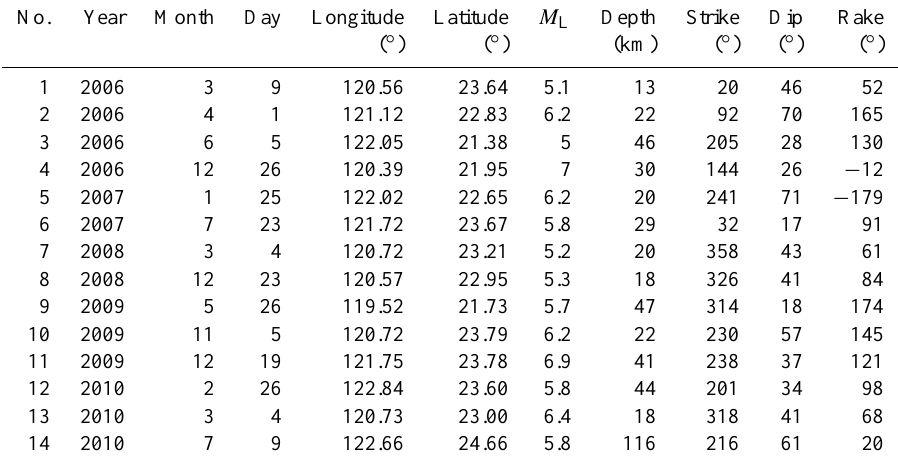
Table 1. Source parameters for source events used to calculate the seismicity rate change with the rate-and-state friction model. The earth- quakes of M L ≥ 5.0 that occurred from 2006 to 2010 were considered. The parameters of focal mechanism are determined by the Broadband Array in Taiwan for Seismology (BATS, http://bats.earth.sinica.edu.tw/). No. Year